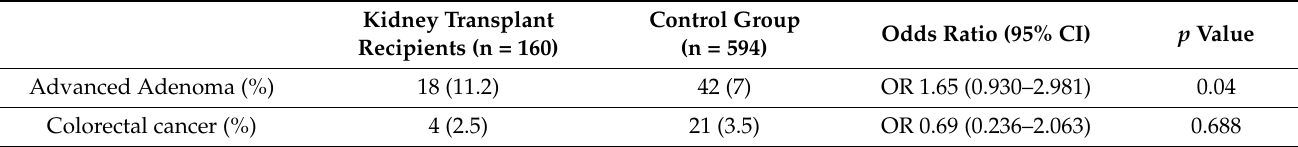
Table 4. The incidence of colorectal neoplasm between kidney transplant recipients and a healthy control. Kidney Transplant Recipients (n =